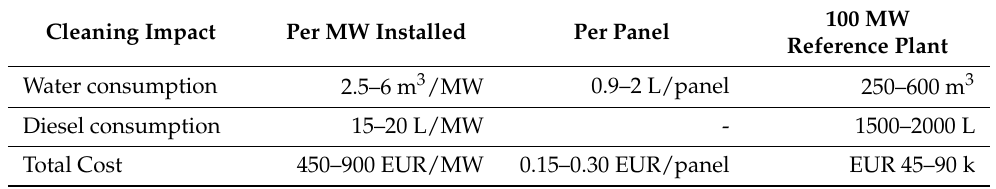
Table 1. Impact of conventional tractor cleaning in large PV plants.